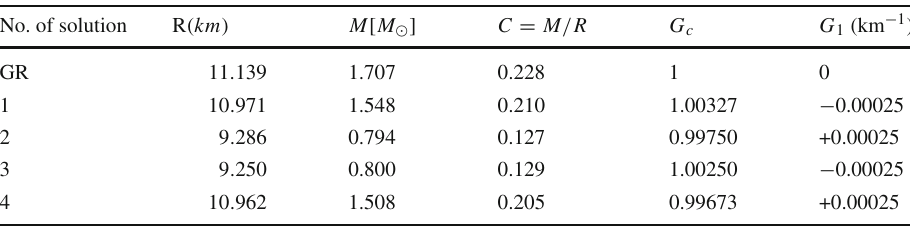
Table 1 Basic properties of the five interior solutions obtained